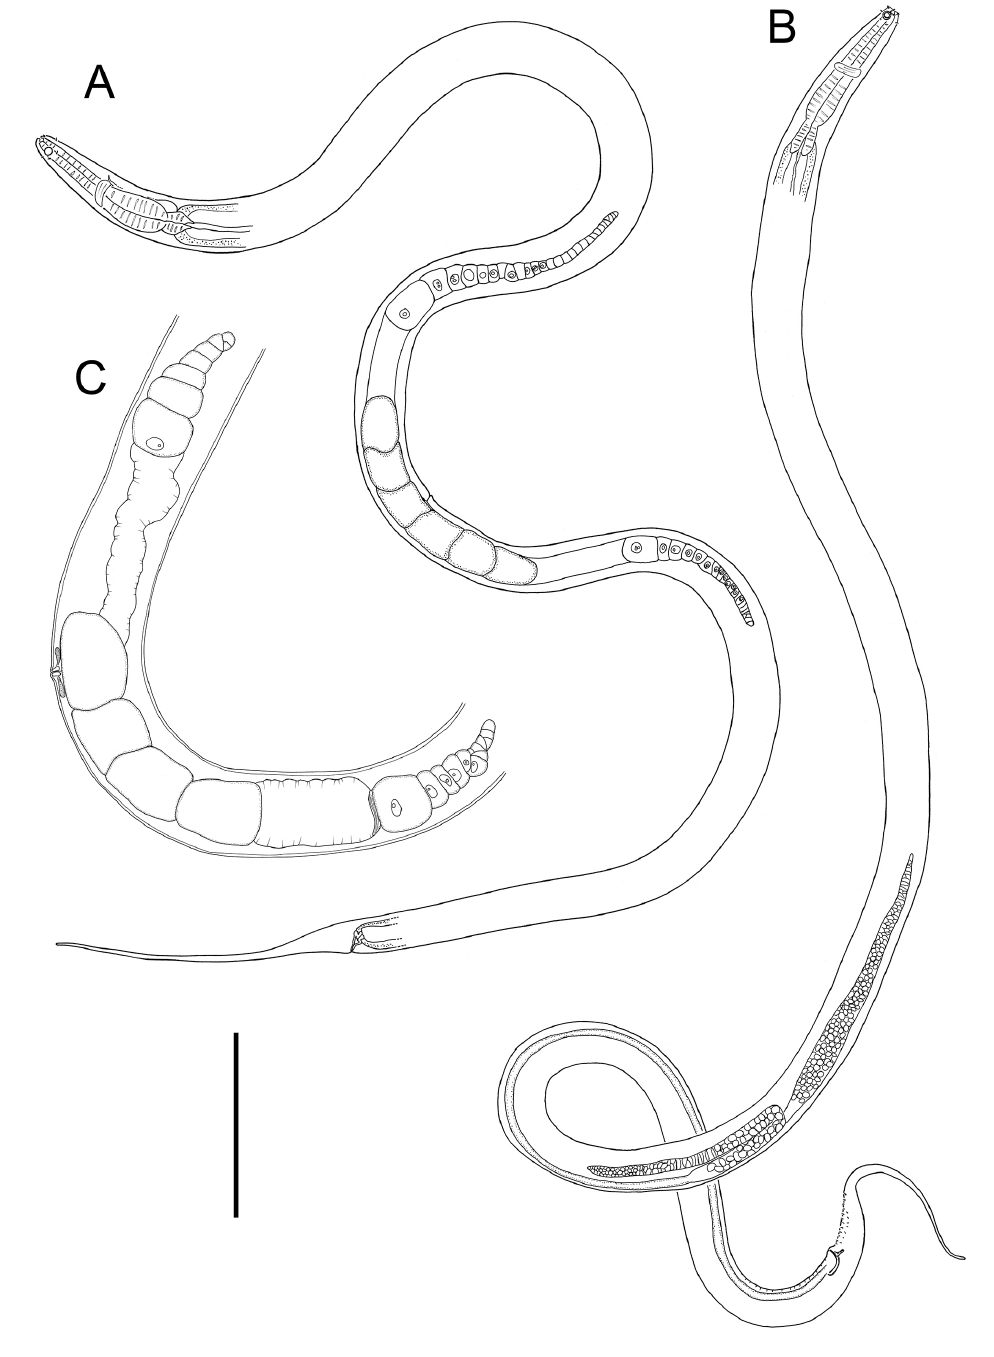
Fig. 5. Linhomoeus pycnocricus sp. nov. A . Entire female, paratype (NIWA154909). B . Entire male, paratype (NIWA154907). C . Female reproductive system, paratype (NIWA154910). Scale bar: A–B = 500 µm; C = 275